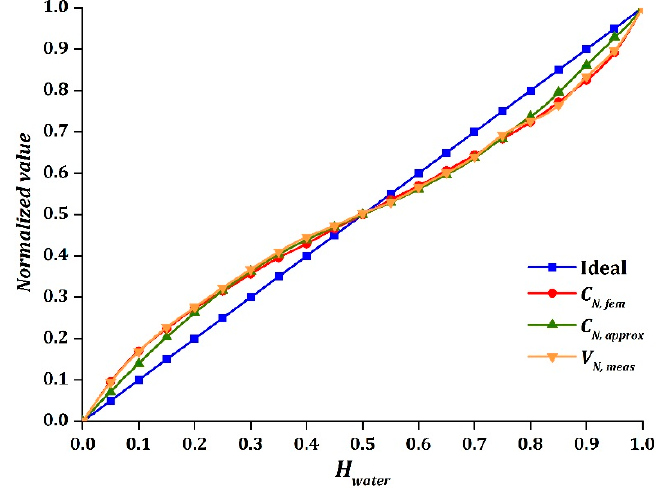
Figure 13. (cid:1829) (cid:3015),(cid:3033)(cid:3032)(cid:3040) , (cid:1829) (cid:3015),(cid:3028)(cid:3043)(cid:3043)(cid:3045)(cid:3042)(cid:3051) , and (cid:1848) (cid:3015),(cid:3040)(cid:3032)(cid:3028)(cid:3046) versus (cid:1834) (cid:3050)(cid:3028)(cid:3047)(cid:3032)(cid:3045) for oil-water stratified flow. Figure 13. C N , fem , C N , approx , and V N , meas versus H water for oil-water stratified